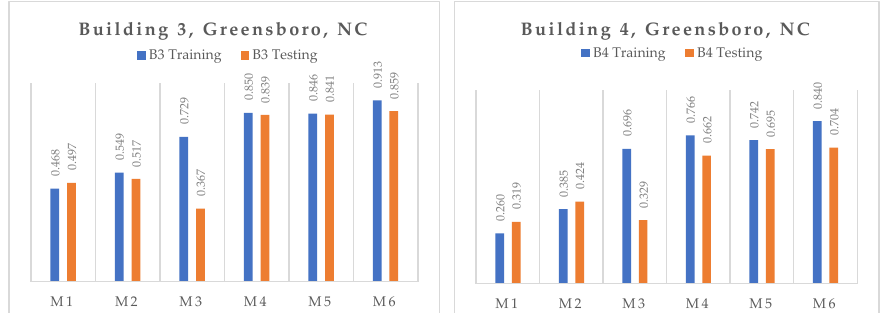
Figure 8. Correlation coefficient values for the training and testing data sets of six models for existing Buildings 3 and 4.